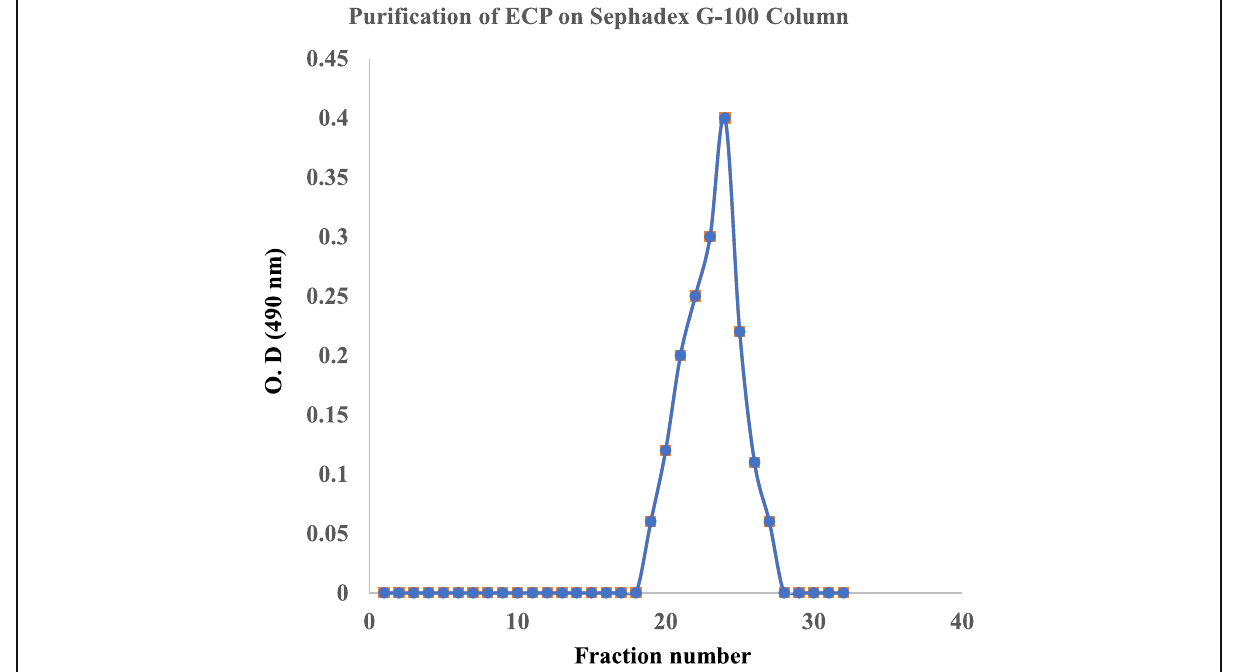
Fig. 1 Purification of ECP on Sephadex G-100 Column. 10 mg/ml was loaded and 0.5 ml was